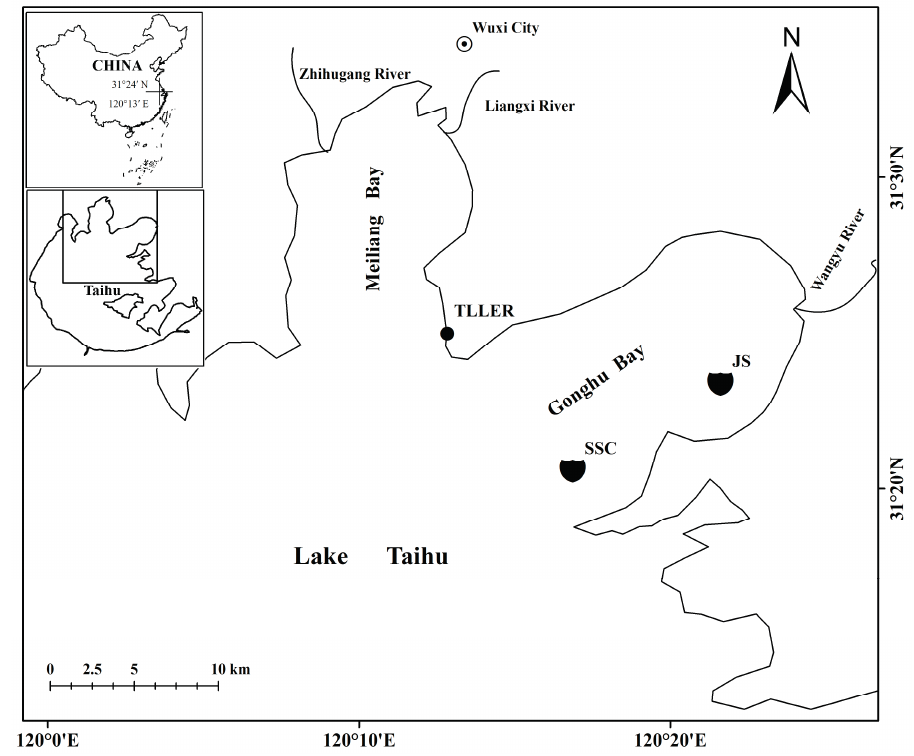
Figure 1. The map of the study area, and the location of the two sampling sites—Shangshancun (SSC) and Jinshu (JS) buoy stations. The downwelling shortwave radiation was collected at the Taihu Laboratory for Lake Ecosystem Research